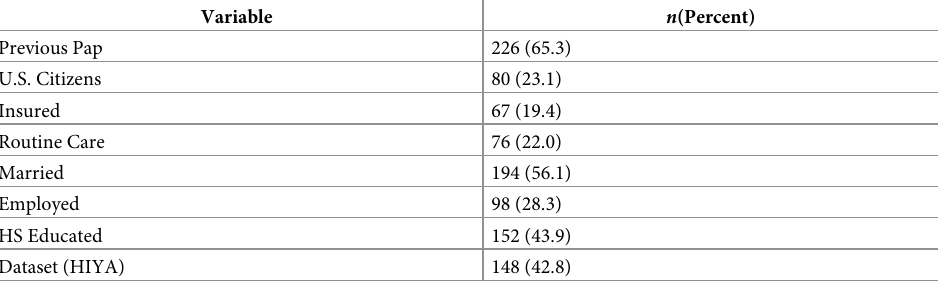
Table 1. Sample descriptive statistics categorical variables ( n = 346).